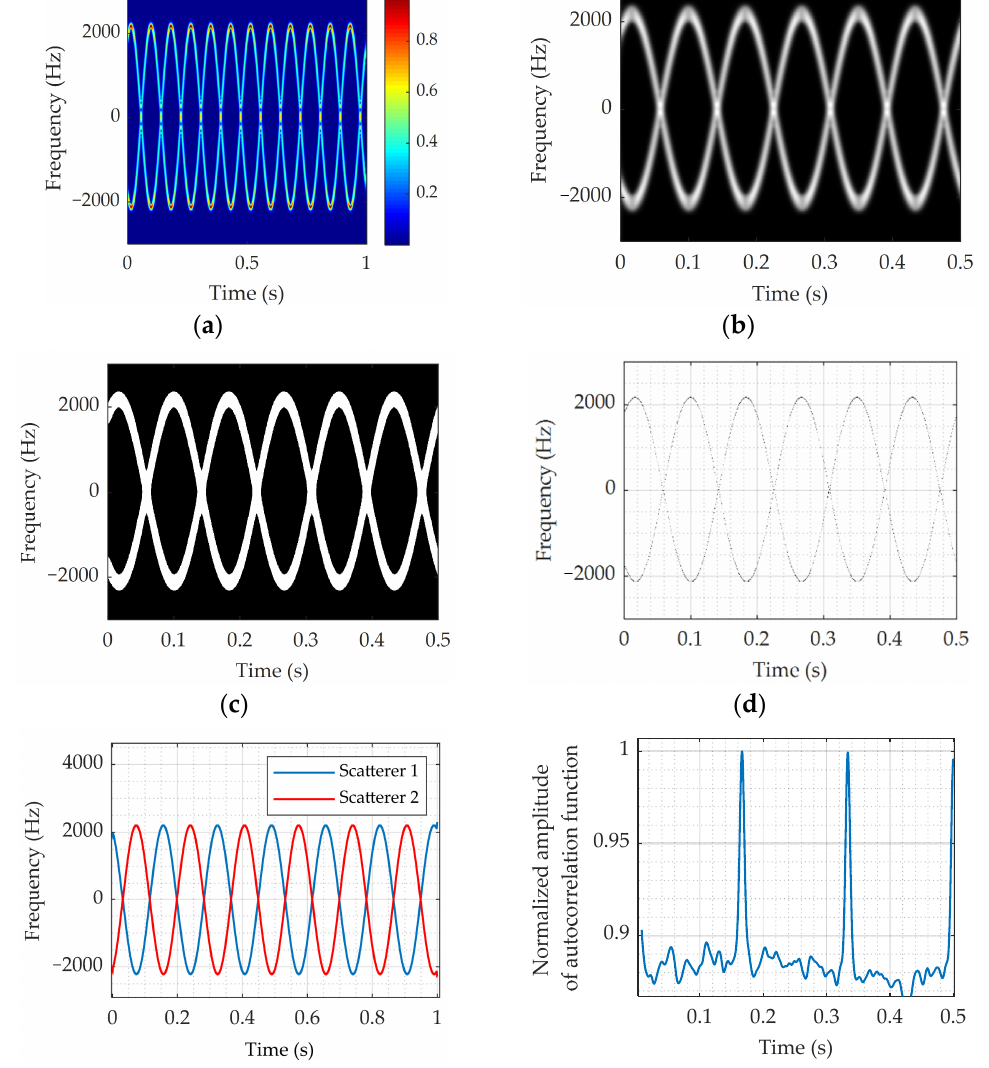
Figure 4. The micro-Doppler effect of the fixed antenna and autocorrelation results. The echo micro-Doppler curves ( a ); The Gaussian mask results ( b ); The binarization results ( c ); The skeleton extraction results ( d ); The micro-Doppler curve separation results ( e ); The variation process of the normalized amplitude with time after autocorrelation processing ( f